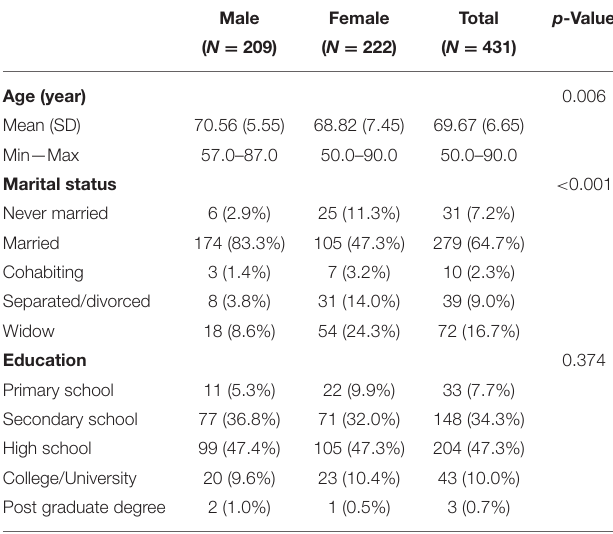
TABLE 1 | Demographic characteristics of study participants ( N =